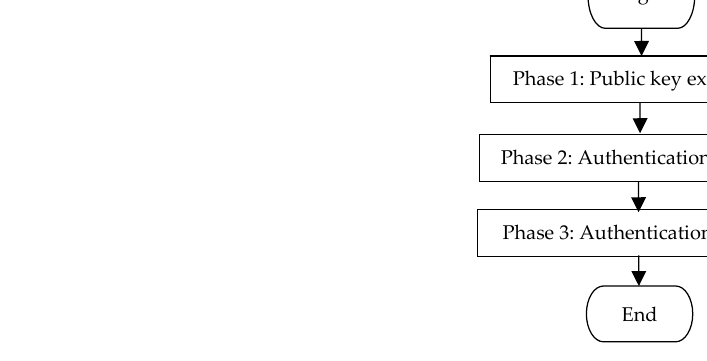
Figure 2. Flowchart of LESSP protocol.